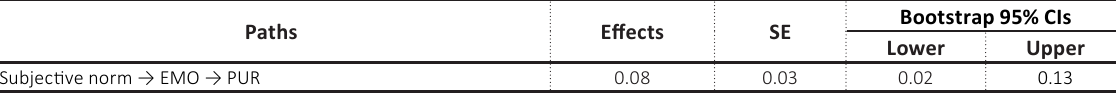
Table 4. Moderation effects of face consciousness